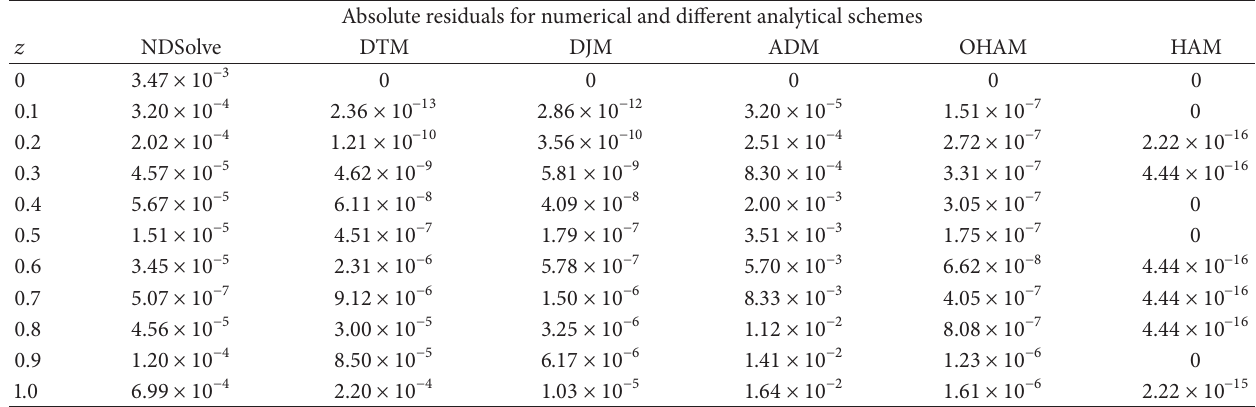
Table 8: Comparison of HAM with numerical and other analytical